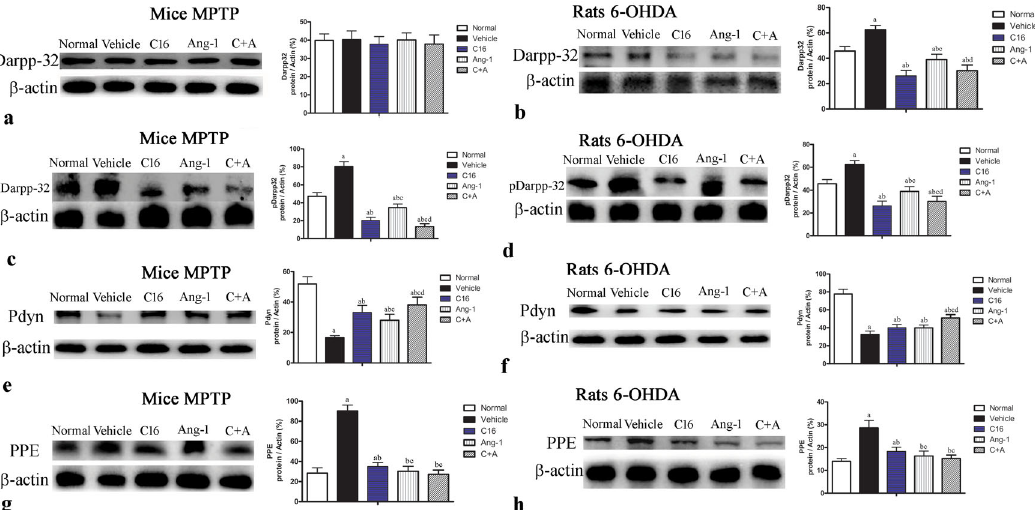
Fig. 15 C16 in combination with Ang-1 treatment decreased the expression of phospho-DARPP-32, and increased the expression of pdyn and PPE. Western blot analysis showed no signi fi cant difference in the expression of DARPP-32 among the different groups ( a , b ). The expression of phospho-DARPP-32 in the vehicle-treated group was higher than that in normal controls ( c , d ). The combination of C16 and Ang-1 inhibited the upregulation of phospho-DARPP-32 in model animals. The downregulation of prodynorphin (pdyn, e , f ) and the upregulation of preproenkephalin (PPE, g , h ) in the model groups were remarkably reversed by treatment with C16, Ang-1, and C16 plus Ang- 1. a p < 0.05 versus the normal control group; b p < 0.05 versus the vehicle group ( c ), p < 0.05 versus the C16-treated group ( d ), p < 0.05